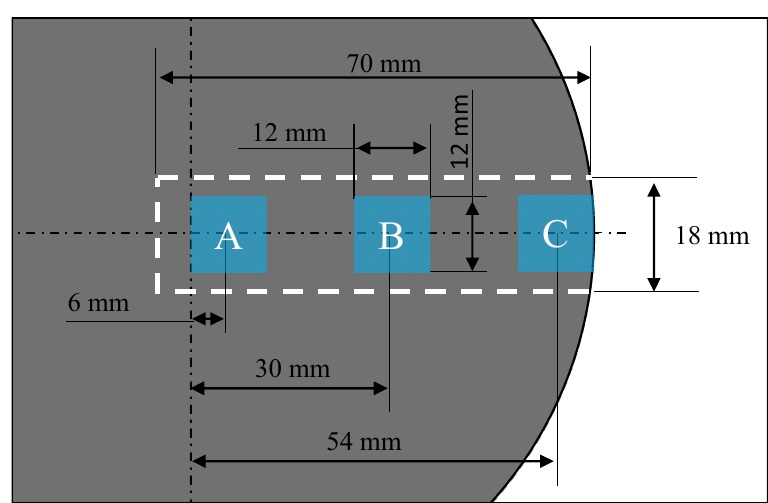
Figure 9. Segmentation of the fiber ‐ reinforced discs for fiber orientation analysis; Segments A, B, and C (blue) are analyzed within VGSTUDIO MAX.